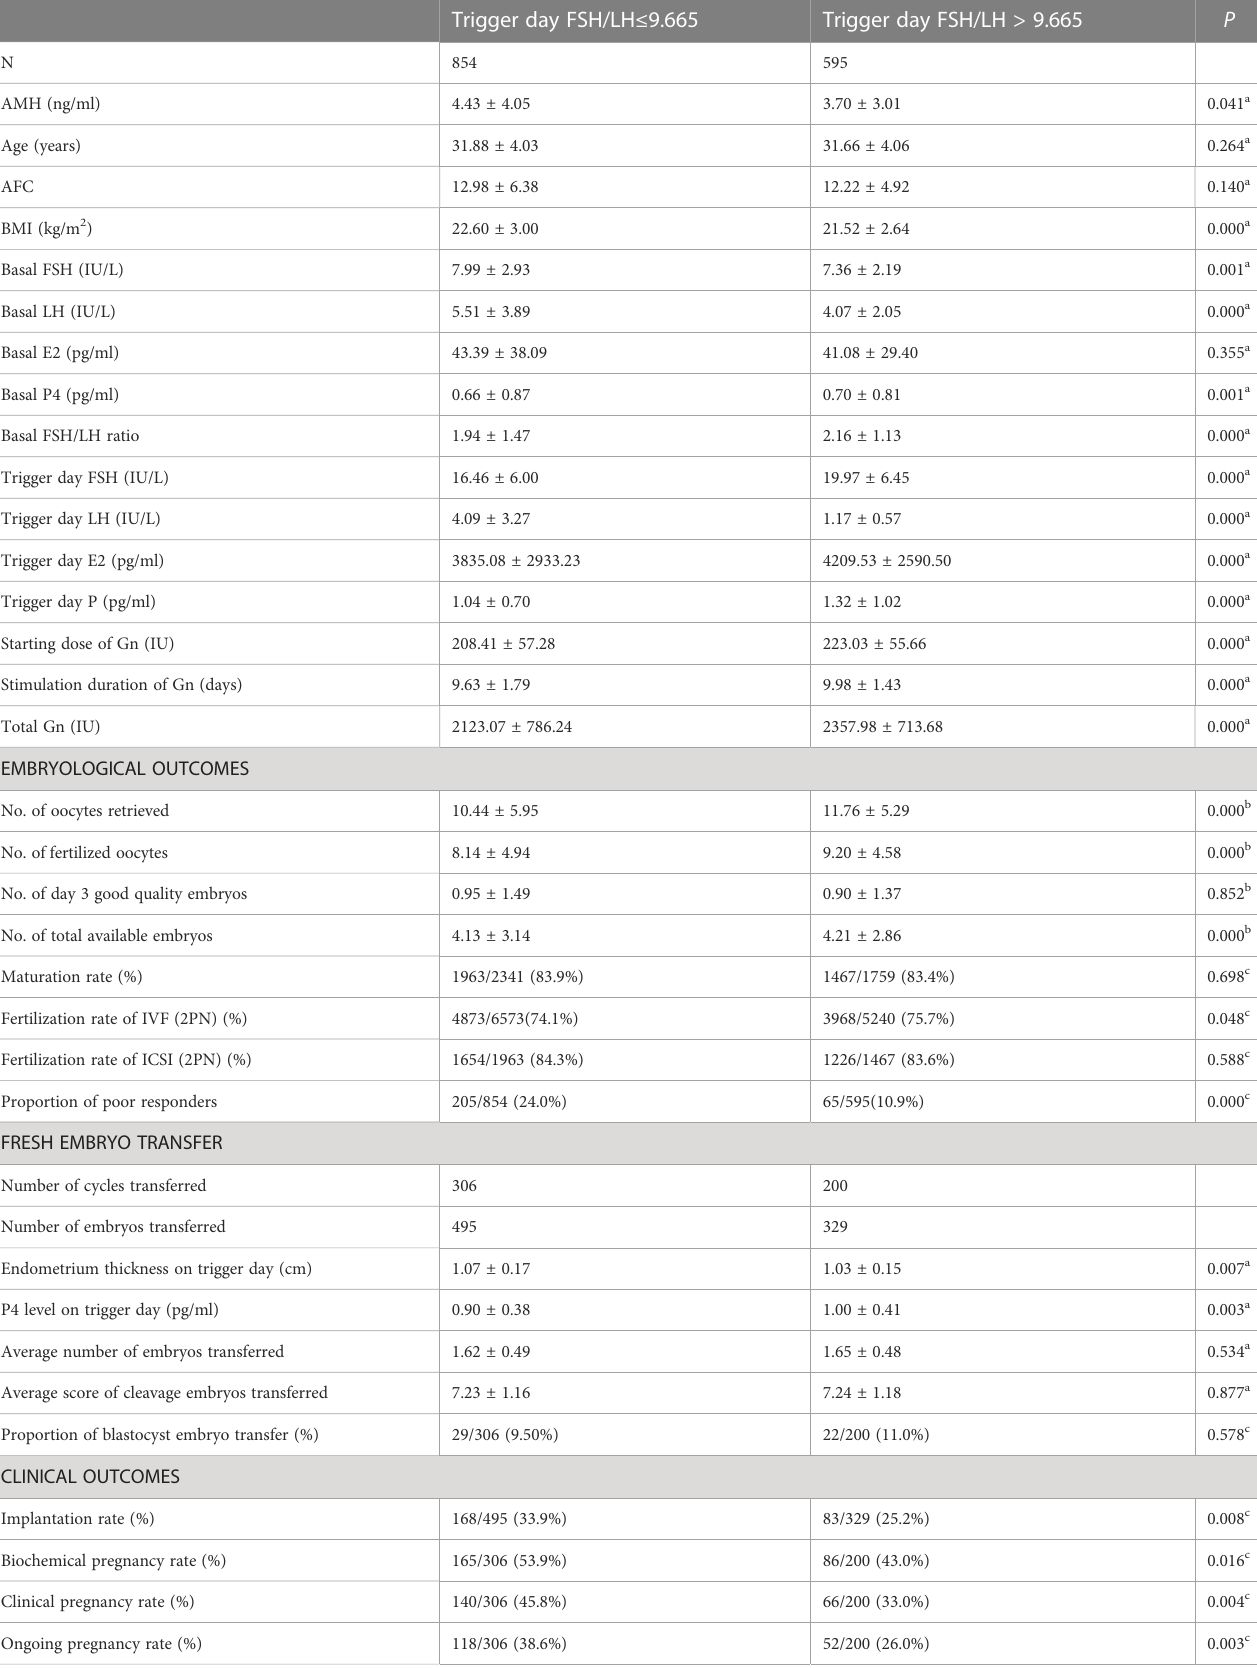
TABLE 5 Basic characteristic, embryological outcomes and clinical outcomes of subgroups based on the trigger day FSH/LH ratio cutoff value for poor